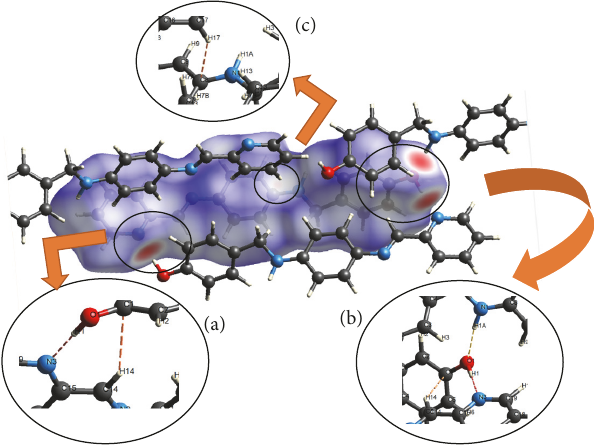
Figure 8: View of EPAF d surface showing the interactions norm O1-H1...N3 e C14-H14...C1 (a), N1-H1A...O, O1-H1...N3, and C14- H14...C1 (b), and C17-H17...C8 (c).